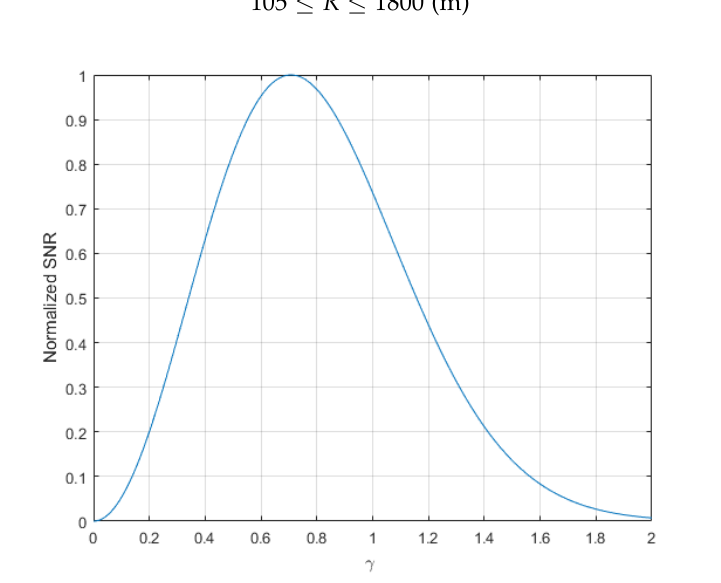
Figure 10. Behaviour of the normalized SNR as a function of γ (Equation